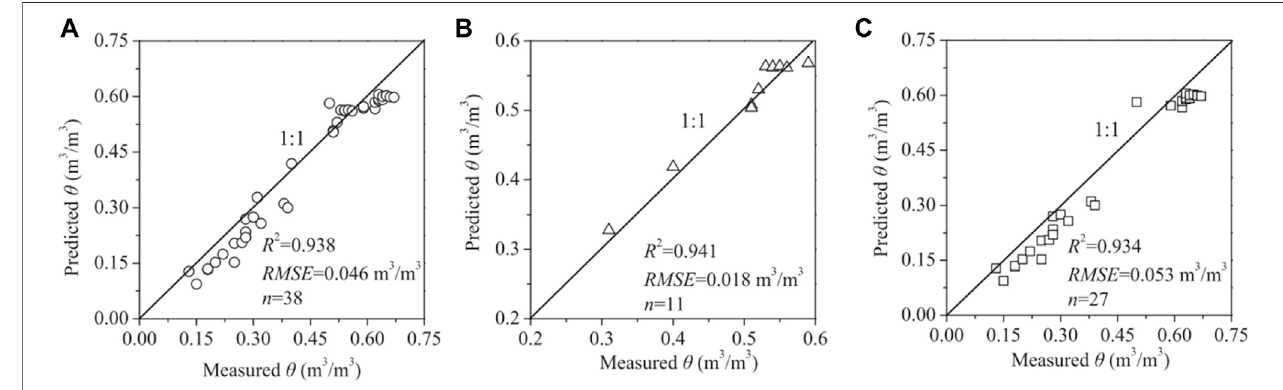
FIGURE 12 | PI-FBG humidity sensor and calibration test device. (A) Inner structure of PI-FBG humidity sensor. (B) Calibration test device (Guo et al., 2021a; Guo et al., 2021b).